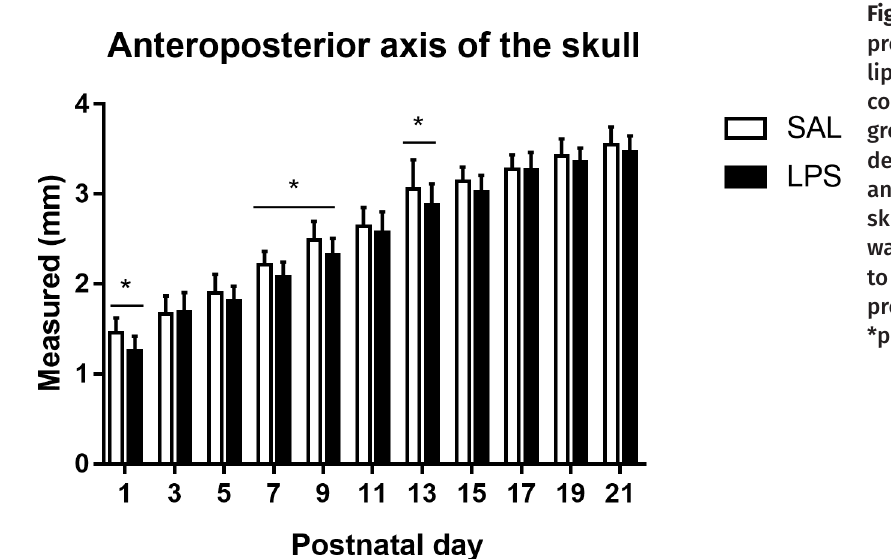
Figure 1. Effects of prenatal exposure to lipopolysaccharide (LPS), compared to the control group (SAL), on the development of rats: the anteroposterior axis of the skull (n=120). The evaluation was performed from the 1st to the 21st day of life. Data presented on average ± S.D. *p <